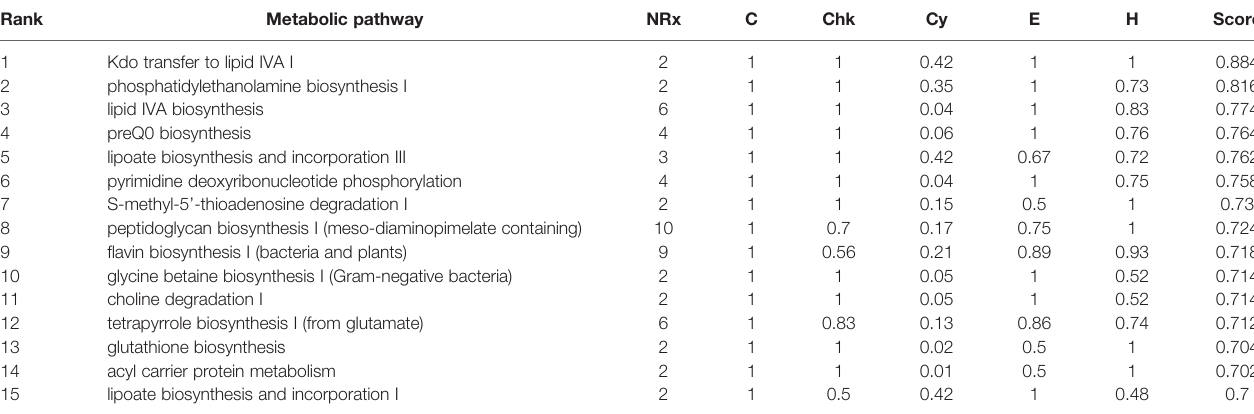
TABLE 2 | Top 15 best ranked metabolic pathways according to completeness, number of choke-points, essentiality, centrality and human off-targets, in which the last column represents the composite scoring scheme detailed in Eq.